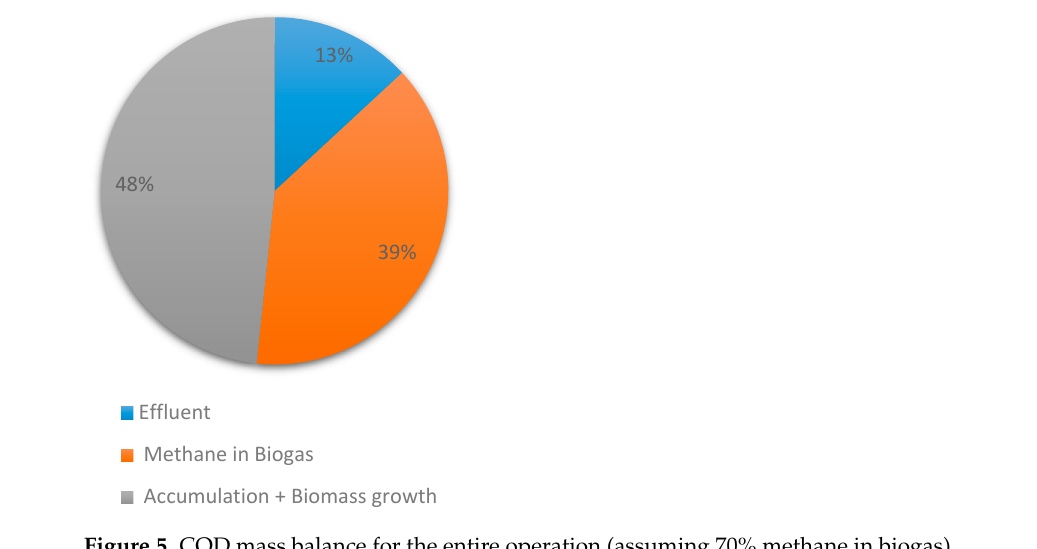
Figure 5. COD mass balance for the entire operation (assuming 70% methane in biogas).